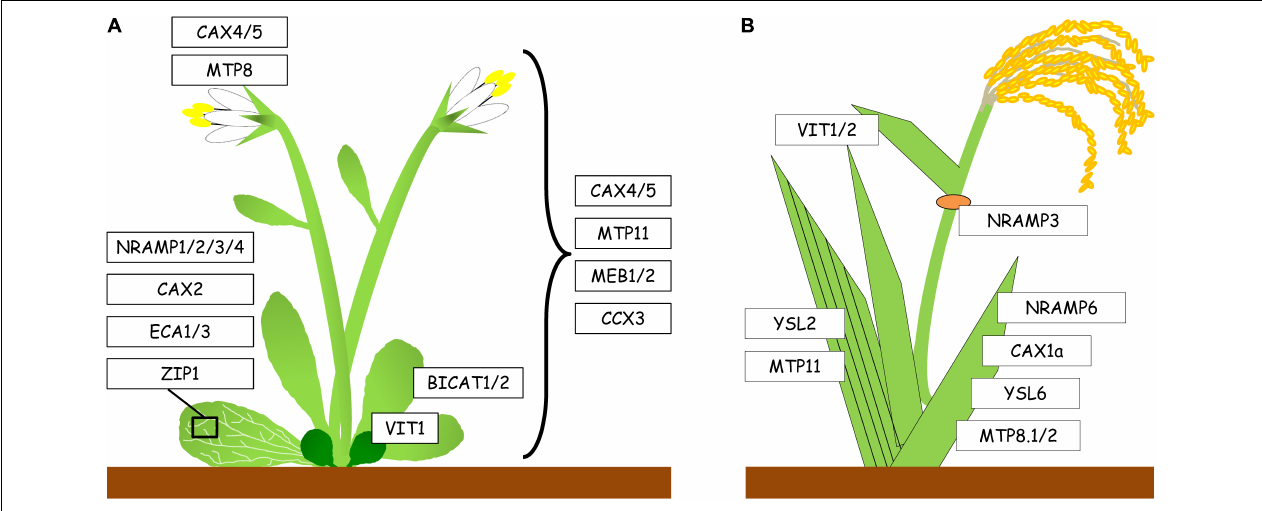
FIGURE 2 | Expression of genes encoding Mn transport proteins in aerial parts of Arabidopsis and rice. (A) Mn transport proteins in shoots of Arabidopsis. Transporters listed on the left are expressed in the vasculature of leaves, transporters listed on the right are expressed throughout the above-ground tissues of the plant. In vegetative tissues, AtVIT1 is only expressed in cotyledons. (B) Mn transport proteins in shoots of rice. OsMTP11 and OsYSL2 are expressed in the vasculature. OsNRAMP3 is expressed in the first node (orange). OsYSL6 and OsMTP8.1/2 are expressed in older leaves, whereas expression of OsVIT1/2 is more pronounced in younger